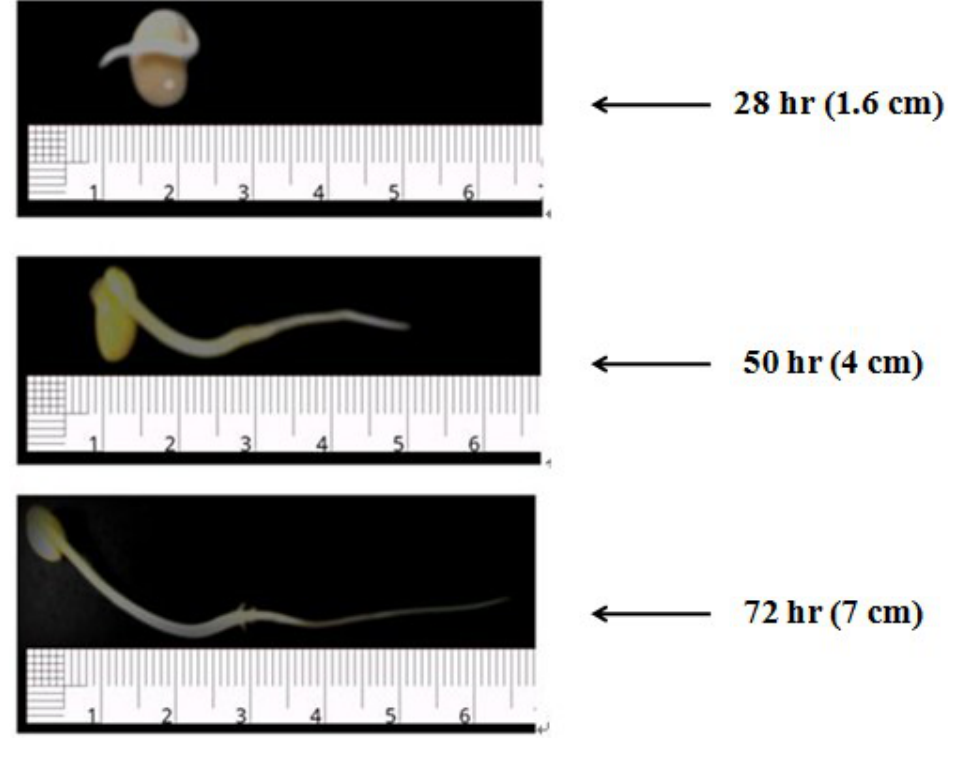
Figure 3. Radicle development of soybeans germinated for different times. The average length of radicles were sampled and given in